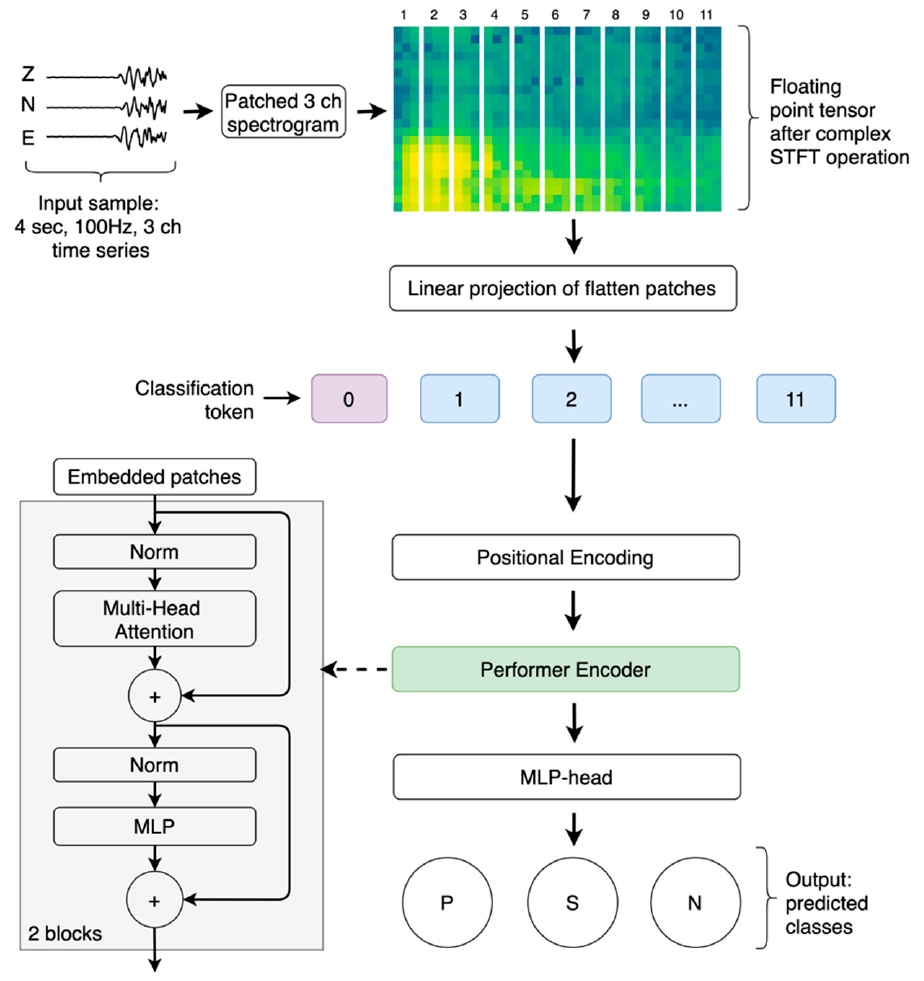
Figure 1. Seismo-performer model overview.